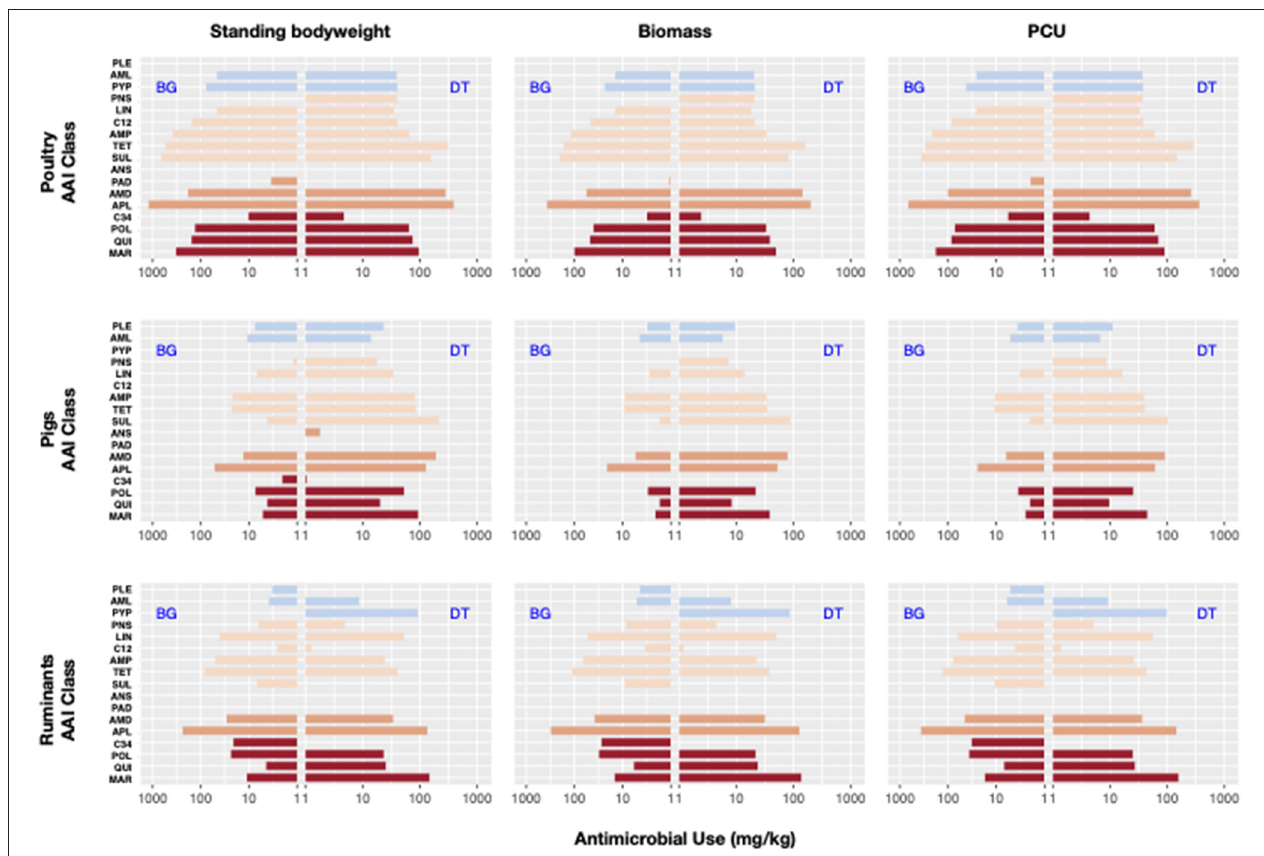
FIGURE 2 | Estimation of annual AMU sales for poultry, pigs and ruminants by three different metrics in surveyed districts in Bac Giang and Dong Thap provinces. x-axis: estimation of annual AMU sales (mg/kg) by three different metrics; y-axis: the surveyed districts in Bac Giang and Dong Thap provinces; Blue, important antimicrobial group; Light Brown, highly important antimicrobial group; Brown, high priority antimicrobial group; Red, highest priority antimicrobial group; BG, Bac Giang province; DT, Dong Thap province; PCU, Population Correction Unit; AAI, active antimicrobial ingredient; PLE, pleuromutilins; AML, aminocyclitols; PYP, polypeptides; PNS, penicillins (narrow spectrum); lin, lincosamides; C12, 1st-2nd generation cephalosporins; AMP, amphenicols; TET, tetracyclines; SUL, sulphonamides; ANS, ansamycins; PAD, phosphonic acid derivatives; AMD, aminoglycoside; APL, aminopenicillins; C34, 3th − 4th generation cephalosporins; POL, polymyxins; QUI, quinolone; MAR,